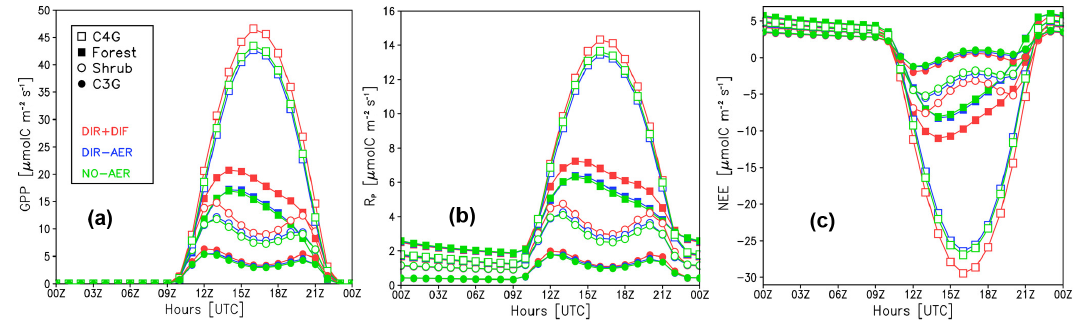
Figure 14. Mean diurnal cycle of (a) GPP (µmolCm − 2 s − 1 ), (b) R P (µmolCm − 2 s − 1 ), and (c) NEE (µmolCm − 2 s − 1 ) during September 2010 for the different biomes in the LBAR. Different symbols indicate the biomes of forest (filled squares), C3G (hollow circles), C4G (hollow squares), and shrubs (filled circles). Different colors indicate the modeling experiments: green is for NO-AER, blue is for DIR-AER, and red is for DIR+DIF.